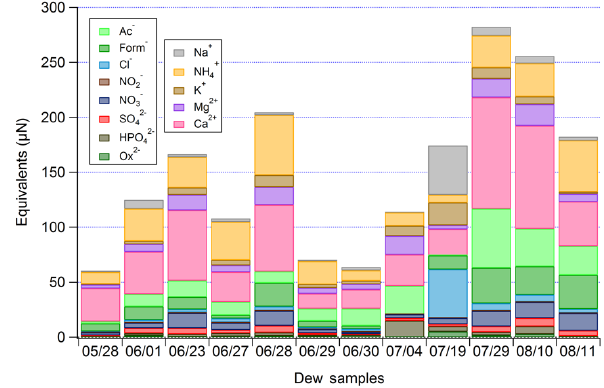
Figure 2. Ionic composition (in µN) of ambient dew collected at